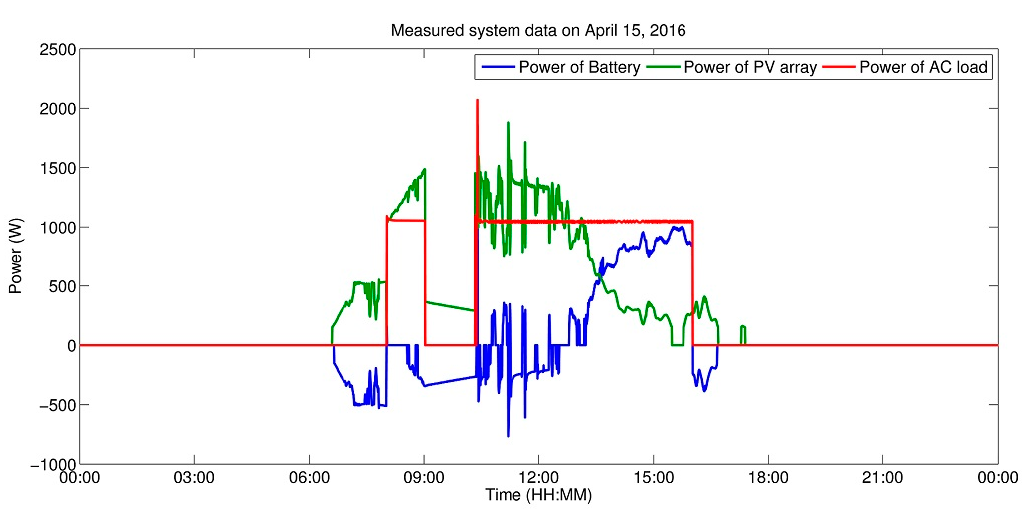
Figure 10. Power profiles measured on physical model of HS.